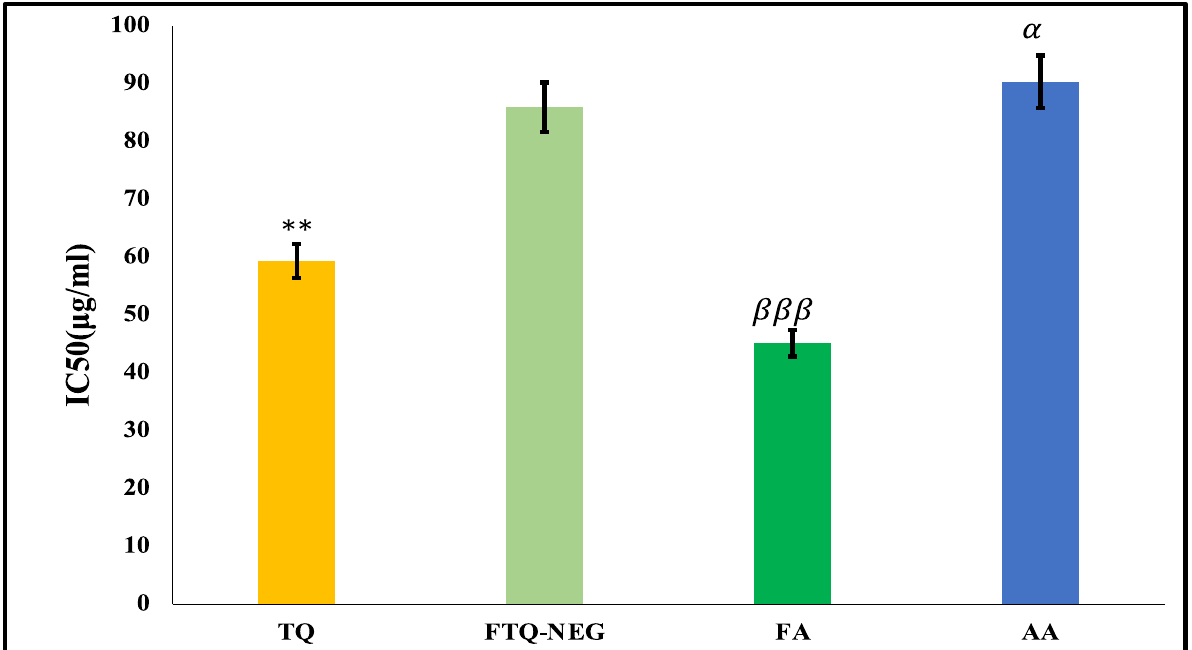
Figure 2. Free radical scavenging activity of the study groups; all the data were found to be significant. Data are expressed as mean ± SD (** p < 0.01, FTQ-NEG vs. TQ), ( βββ p < 0.001, FTQ-NEG vs. FA), ( α p < 0.05, FTQ-NEG vs. AA).